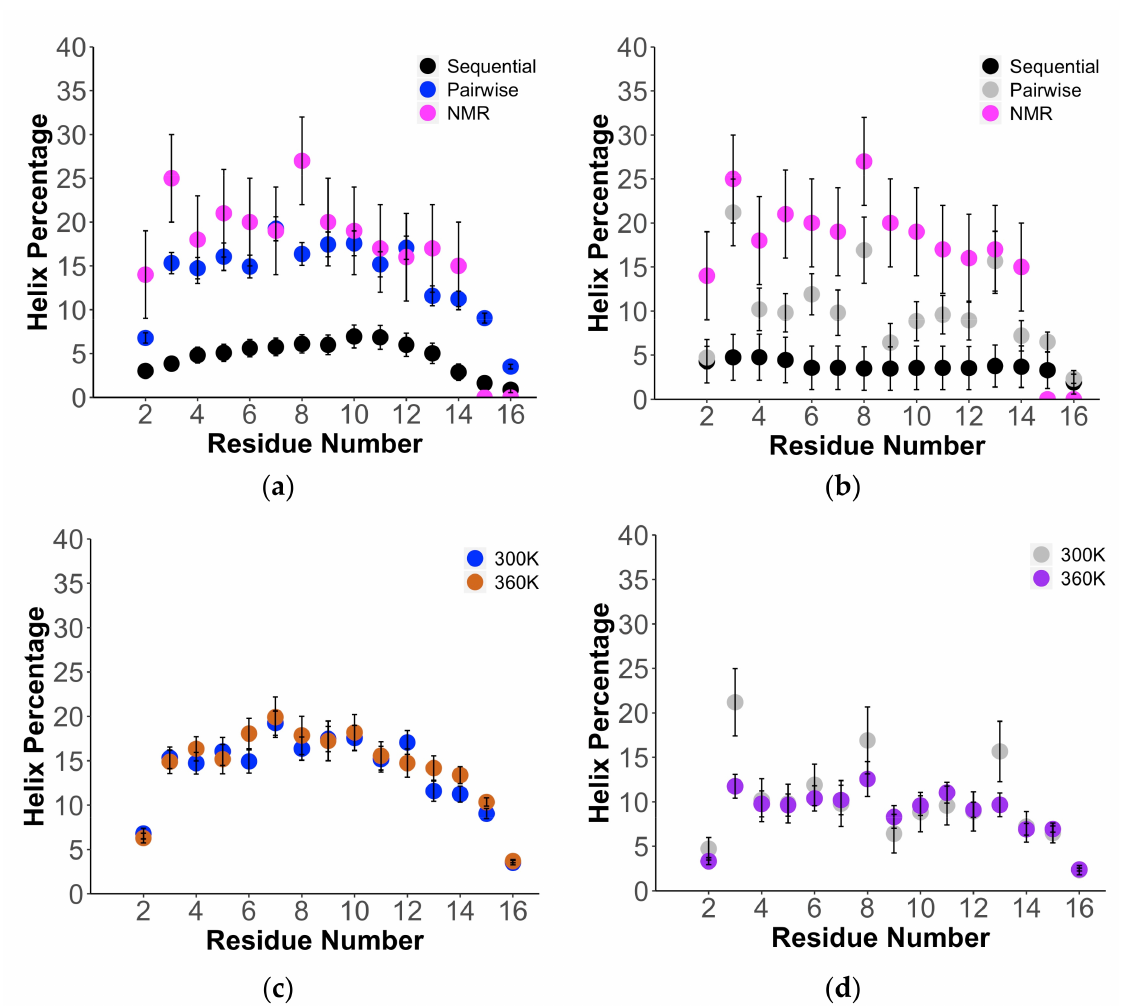
Figure 5. Structural properties for (AAQAA) 3 using polarizable and nonpolarizable force fields. Comparison of estimated helical propensities from NMR (pink), average α − helix from the simulation assuming 3 sequential residues (black), and pair- wise average over any presence of α − helix, π − helix, and 3 10 helix for ( a ) C36m/TIP3Pm (blue) and ( b ) AmPro13/AmW03 (gray) at 300 K. Comparison of changes in helix propensity with temperature at 300 and 360 K for ( c ) C36m/TIP3Pm and ( d )